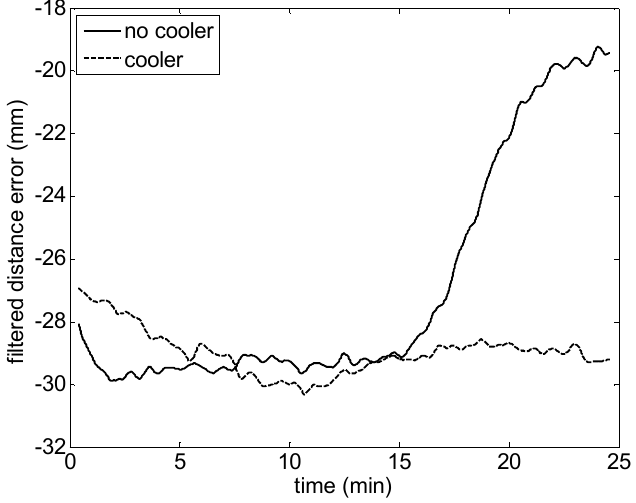
Figure 3. Dynamic evolution of the error in one distance measured with and without cooler